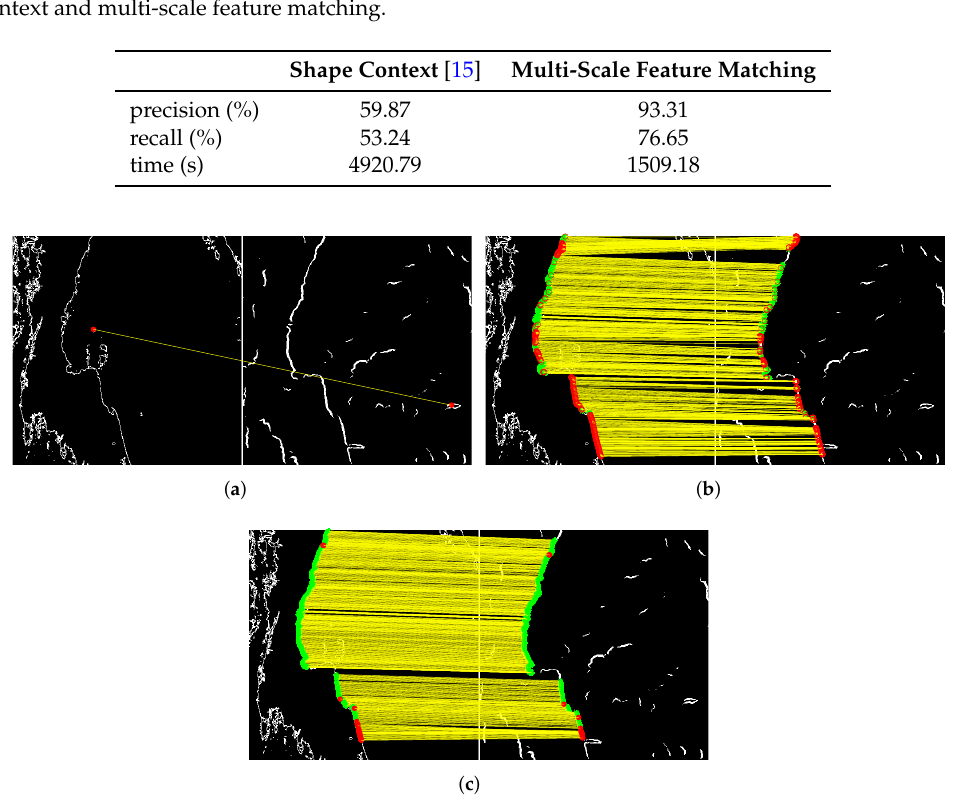
Figure 7. Comparing the matching result of multi-scale feature matching with scale-invariant feature transform (SIFT) and shape context in a pair of patches. The left and right patches are corresponding to the landmark image and the GSMS image, respectively. Besides, green points denote inliers and red points denote outliers. ( a ) SIFT. ( b ) Shape context. ( c ) Multi-scale feature